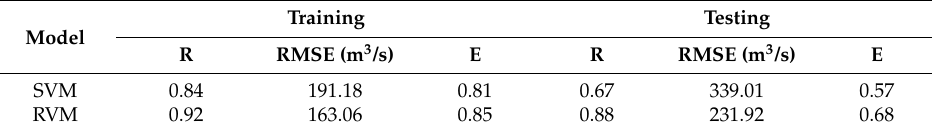
Table 6. Results of indices used to evaluate the performance of the relevance vector machine (RVM) and support vector machine (SVM) model for streamflow forecasting in the Danjiangkou Reservoir.